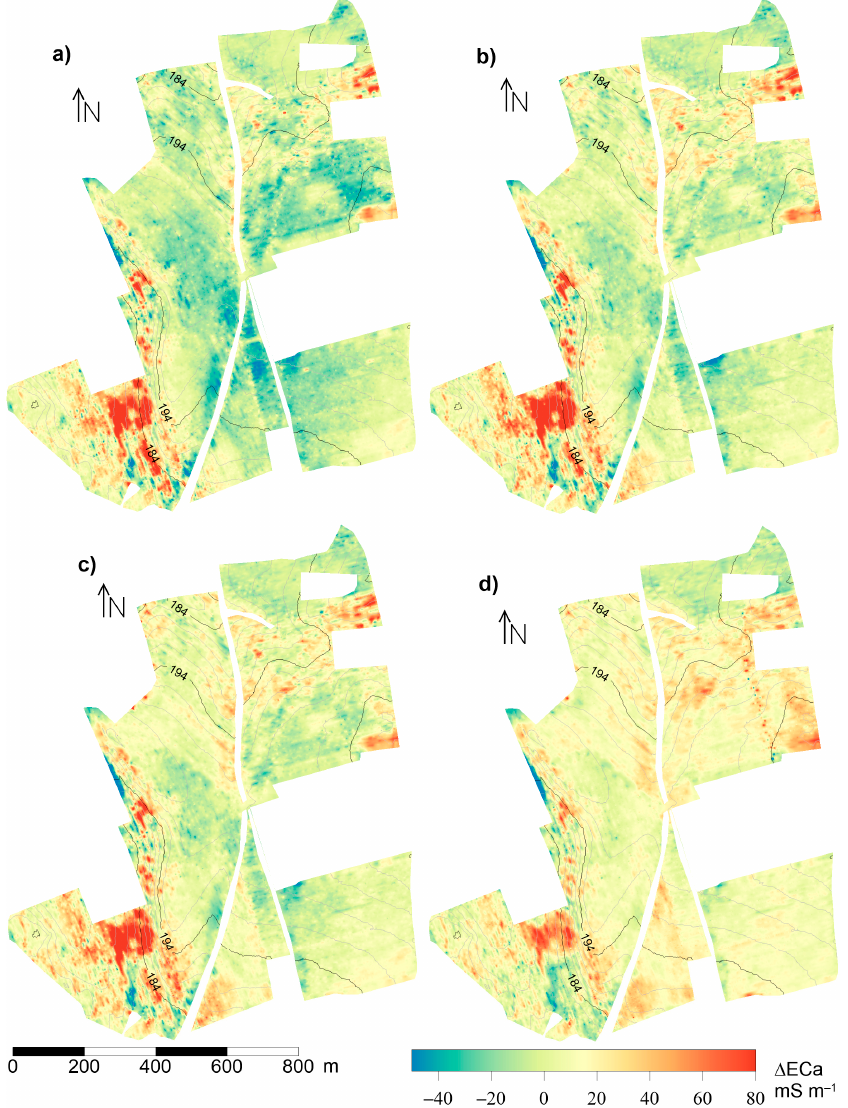
Figure 3. Spatial distribution of the increments in ECa between 2013 and 2017 ( ∆ ECa) for DOEs of ( a ) 0–0.5 m; ( b ) 0–1.0 m; ( c ) 0–1.5 m and ( d ) 0–3.0 m.